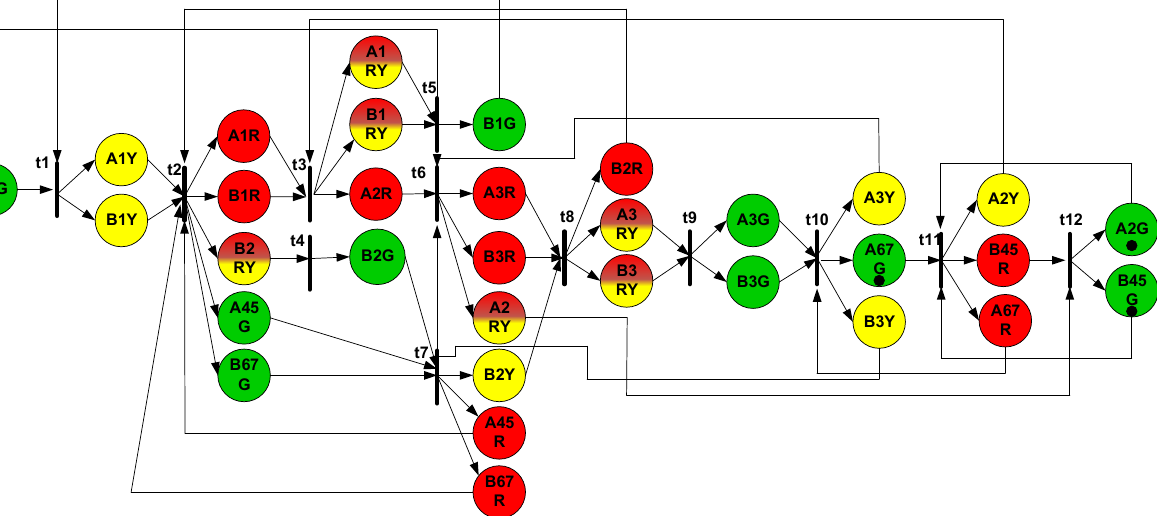
Figure 5. Corrected (final) specification of the crossroad traffic light system.